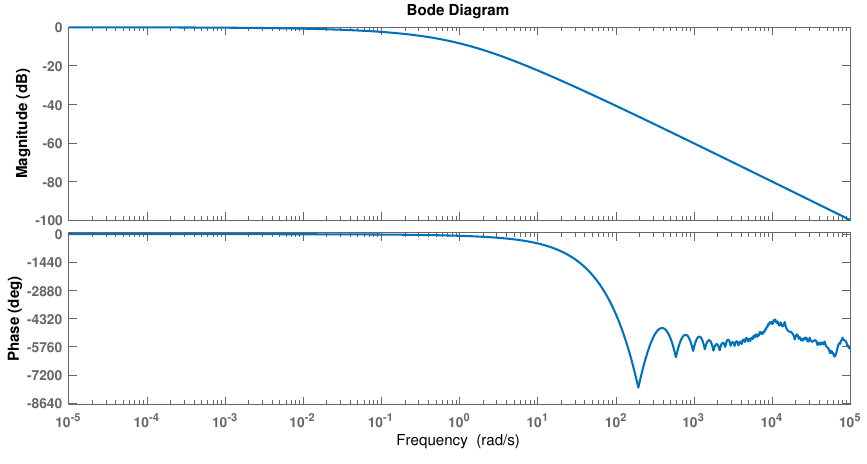
Figure 7. The bode diagrams of the system (65). The svf parameters are selected respectively as: (cid:118) = 1 rad/s and η =